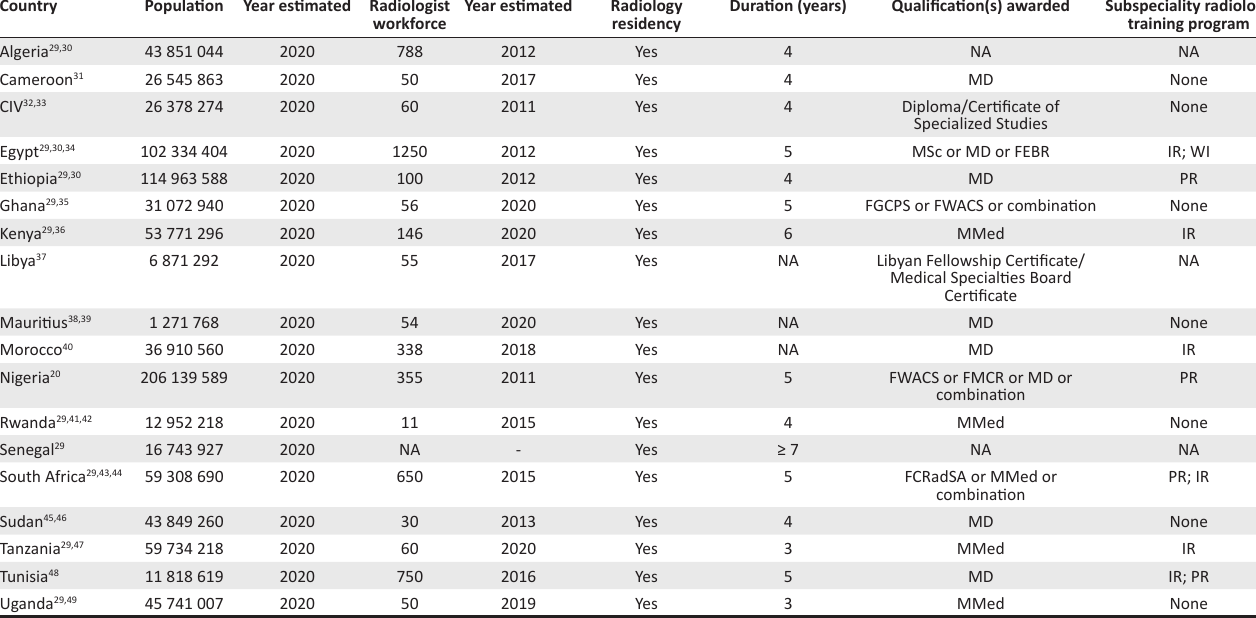
TABLE 1 : Current status of radiology subspecialisation in Africa. Country Population Year estimated Radiologist